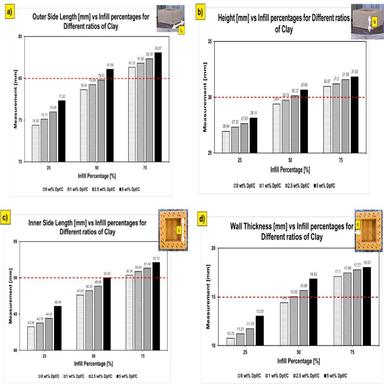
Bar chart demonstrating dimensional accuracy of (a) outer side length, (b) height, (c) inner side length, and (d) wall thickness of the 3DP four wall structures with different infill percentages and different Dpf/C ratios. The designed value for each dimension is represented in the red dotted line in the figure. (For interpretation of the references to colour in this figure legend, the reader is referred to the Web version of this article.)